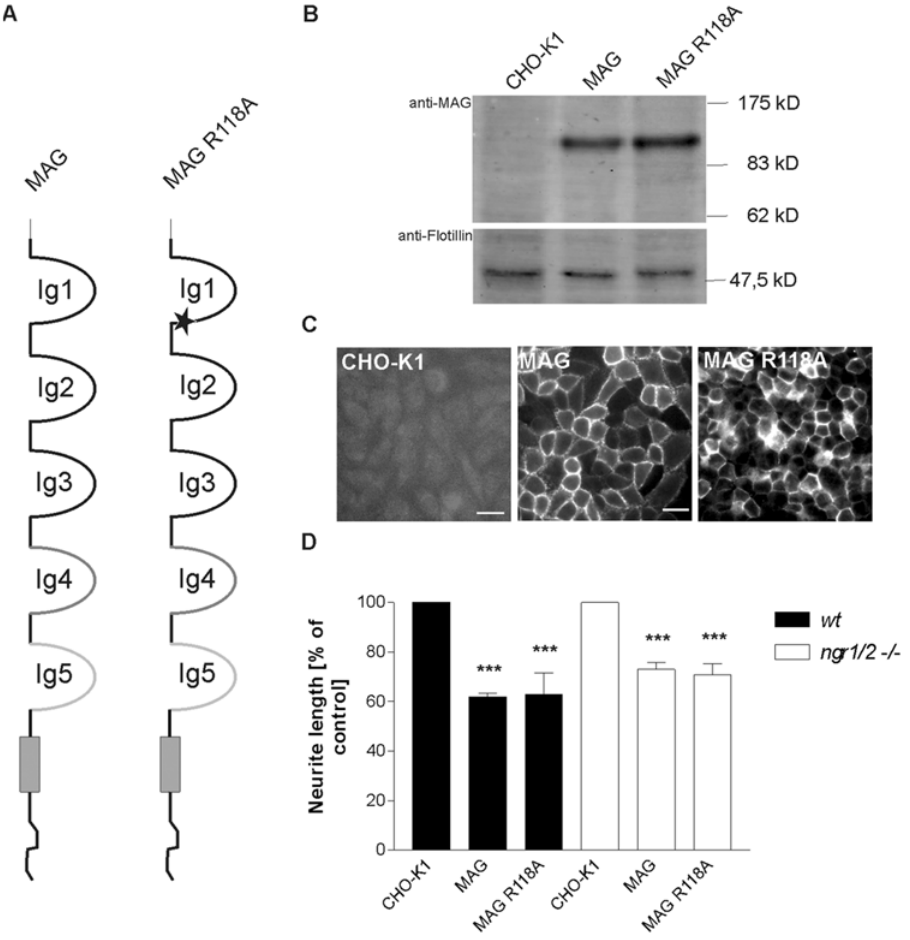
Figure 6. Inhibition of neurite outgrowth by a MAG mutant lacking the sialic acid binding site. (A) The name MAG R118A refers to a point-mutation within the sialic-acid binding domain of MAG (asterisk), that abolishes MAG binding to specific gangliosides. (B) Western Blot analysis of a CHO clone stably expressing MAG R118A. Ten micrograms of total protein lysate were loaded for each lane. Goat anti-MAG antibody was used to detect MAG; to reveal equal protein load, blots were incubated with anti-flotillin antibody. (C) Cell surface expression of full-length MAG and MAG R118A proteins by transfected CHO cells after FACS and clonal selection as revealed by live-staining with anti-MAG antibody. Scale bar 20 m m. (D) Analysis of neurite length of wildtype and ngr1/ngr2 double knock-out DRG neurons grown on CHO cell monolayers expressing full-length MAG or MAG R118A. Parental CHO cells served as the control substrate. Graph shows % neurite length on the different substrates 6 SEM. Three separate experiments were examined for each experimental condition, with 50 to 100 neurons measured for each substrate. *** represents P # 0.001 compared to CHO-K1, one-way analysis of variance with post-hoc Tukey test.